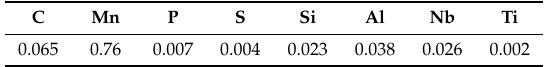
Table 1. The chemical composition of steel S355J2 + N (wt %).